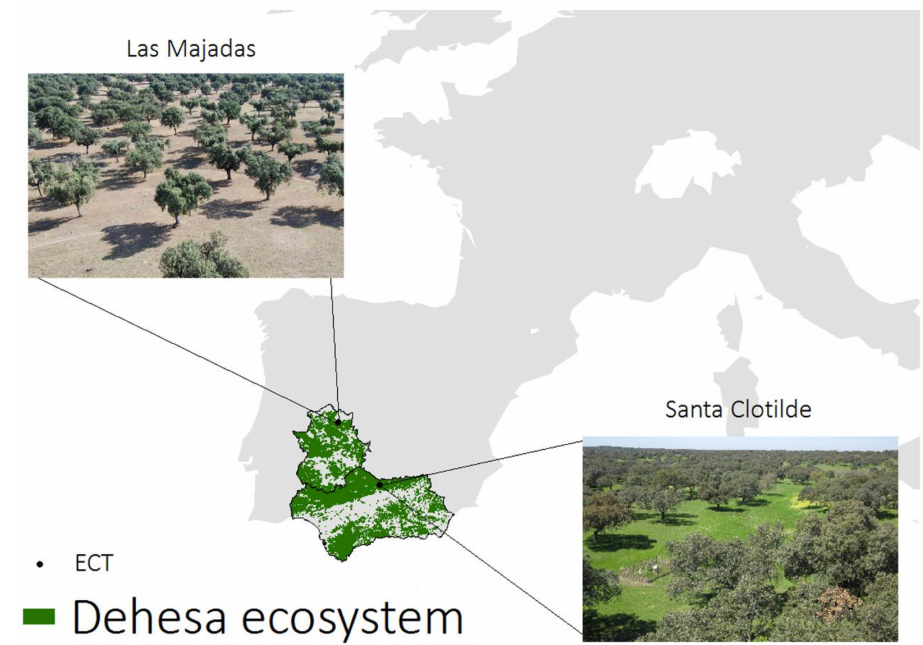
Figure 2. Location of experimental sites, and areas of dehesa ecosystem across Extremadura and